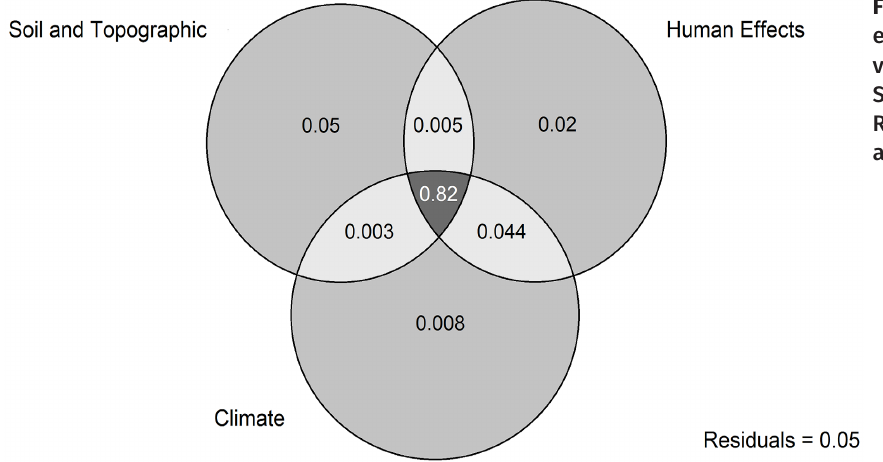
Figure 4. Variance partition explained by each set of variables selected in the best Stepwise Multiple Logistic Regression model for data of